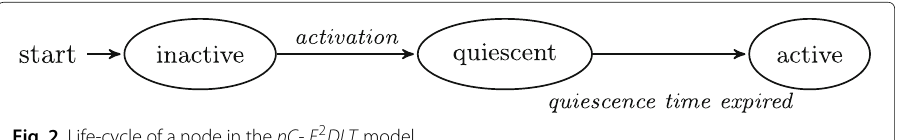
Fig. 2 Life-cycle of a node in the nC - F 2 DLT